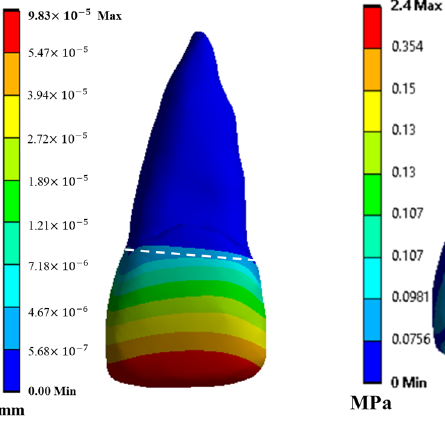
Figure 8. Countours depicting location of maximum values under traumatic load at ( a ) von Mises stress at Enamel, ( b ) von Mises stress at Dentin, and ( c ) shear stress at Dentin.